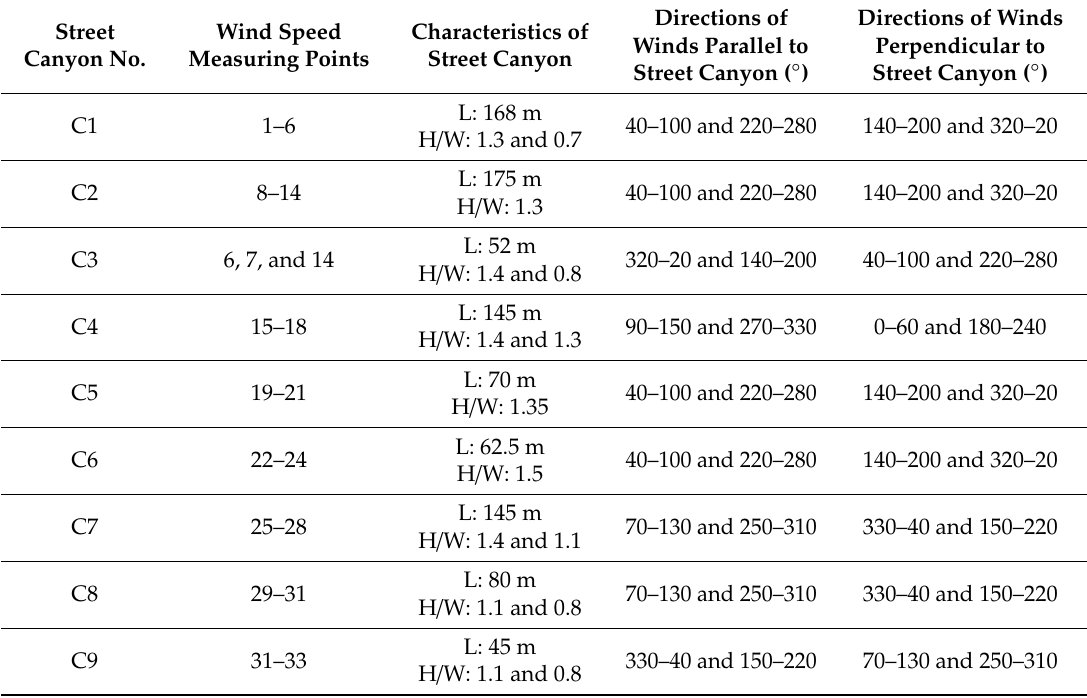
Table 1. Characteristics of street canyons.